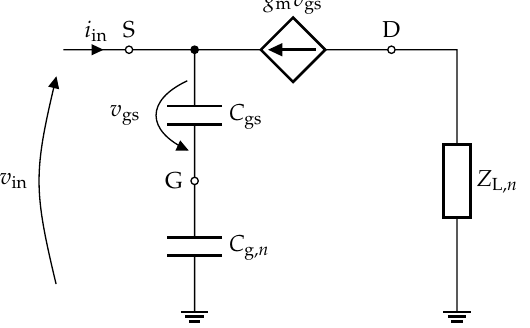
Figure 2. Simplified intrinsic equivalent of the n th CG